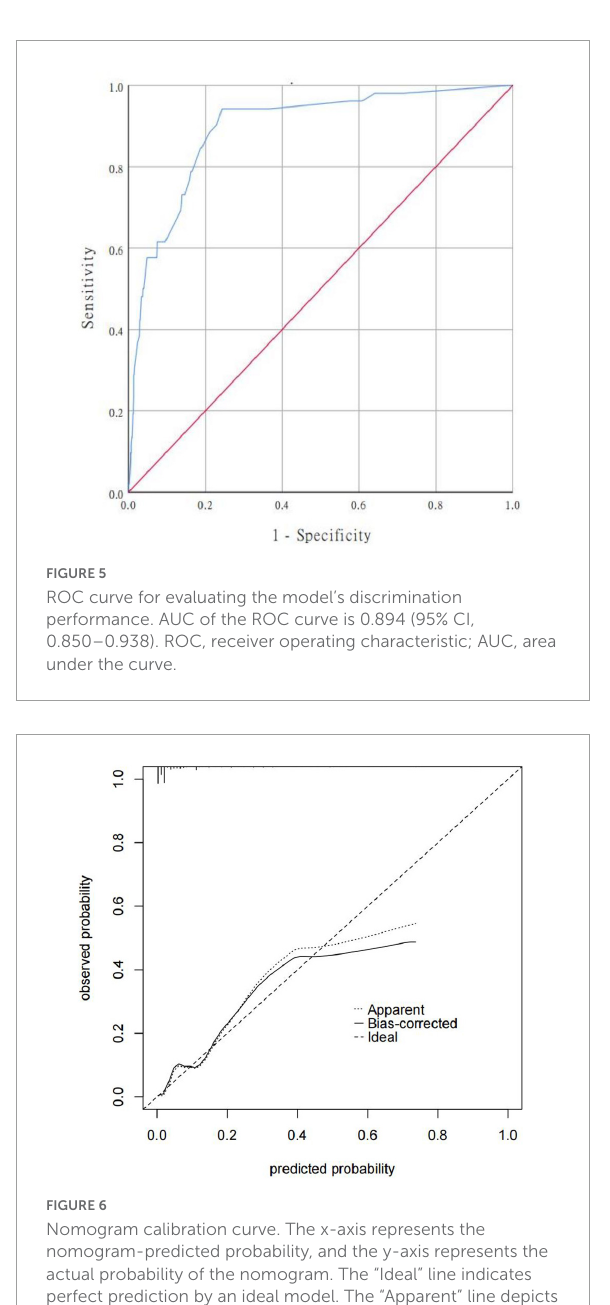
FIGURE8 CIC of the nomogram. Two horizontal axes show the correspondence between cost: benefit ratio and risk threshold. Of 1,000 patients, solid red line shows the total number of high-risk patients for each risk threshold. Dotted red line shows how many of those are with positive event. CIC, clinical impact